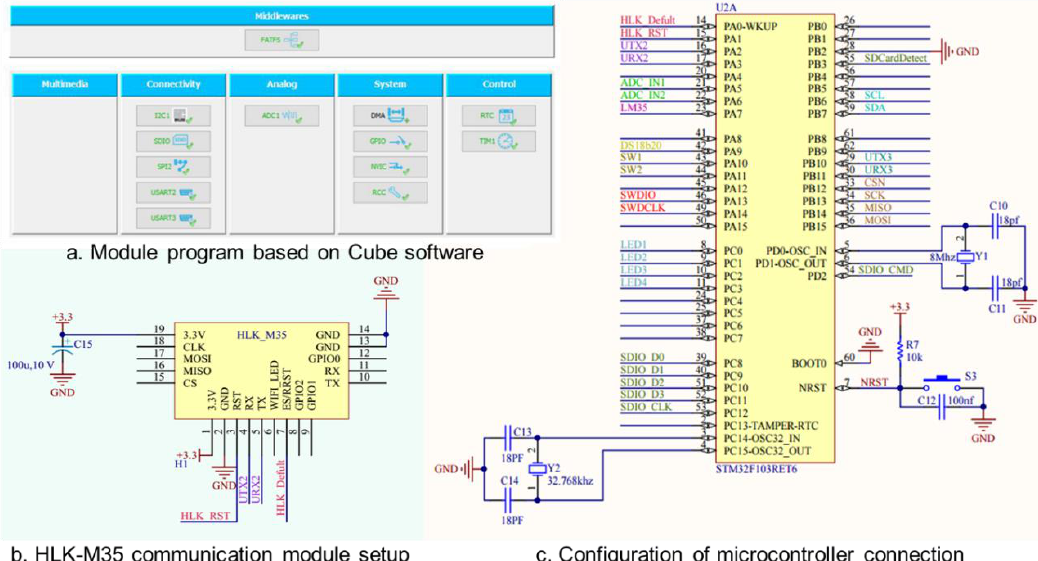
Figure 2. Sensor module program and design.